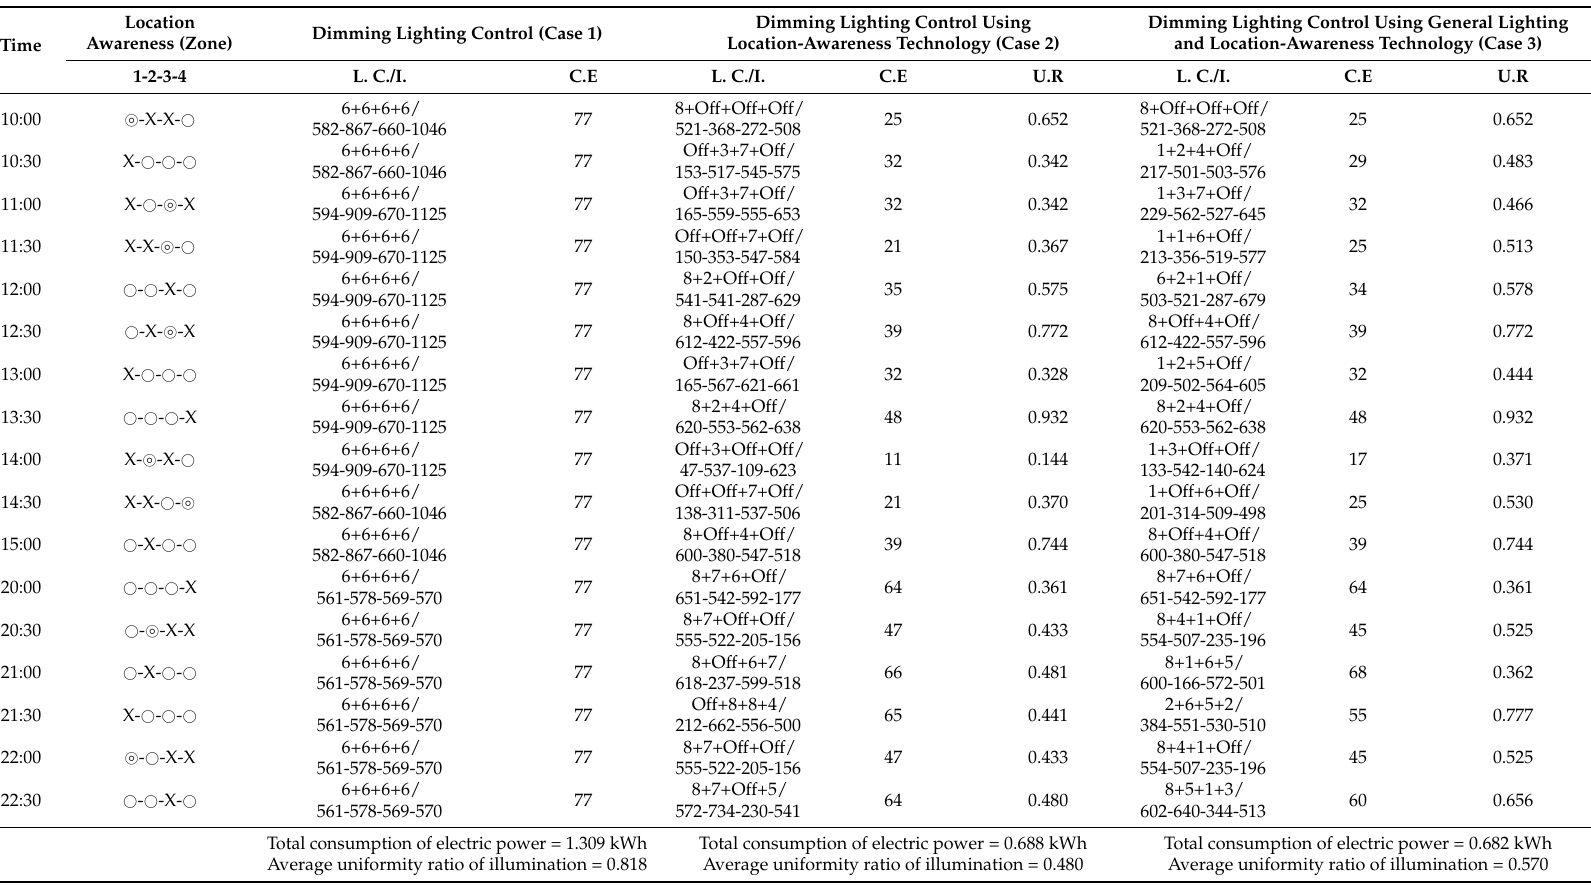
Table 11. Performance evaluation results based on three occupants.